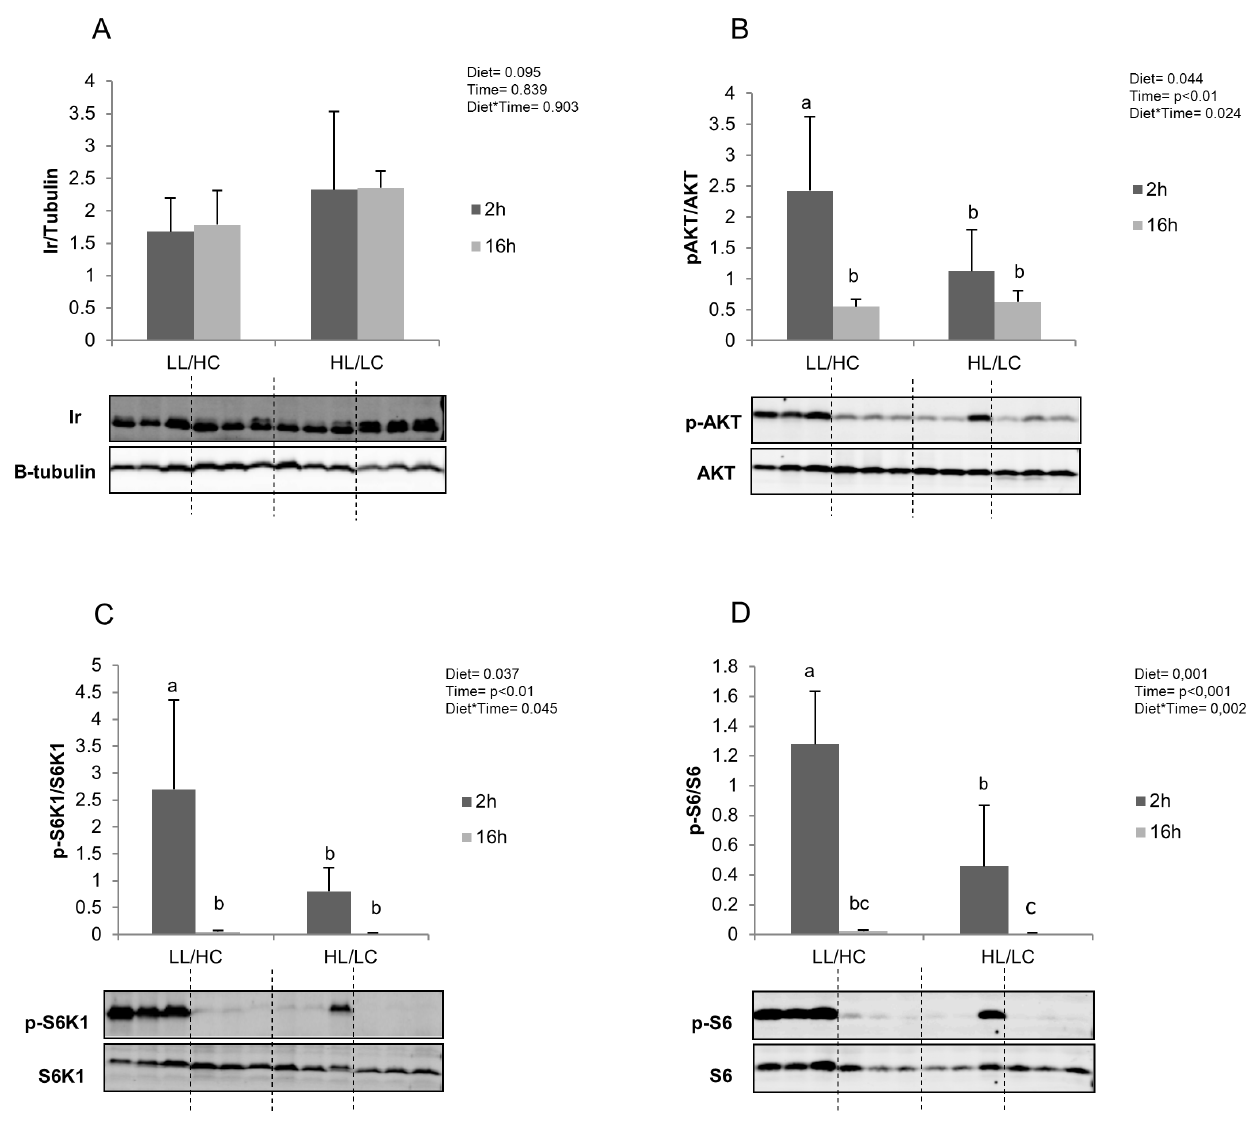
Figure 3. Insulin receptor (IR-A) levels and Akt (B), S6K1 (C) and S6 (D) phosphorylation status in muscle of Senegalese sole fed LL/ HC or HL/LC diet (n=6). Results are expressed as the ratio between total protein and reference protein ( b -tubulin) for IR and ratio between phosphorylated form and total form for the remaining proteins. Representative blots are shown. Data were submitted to a two way ANOVA. Gels were loaded with 40 m g total protein per